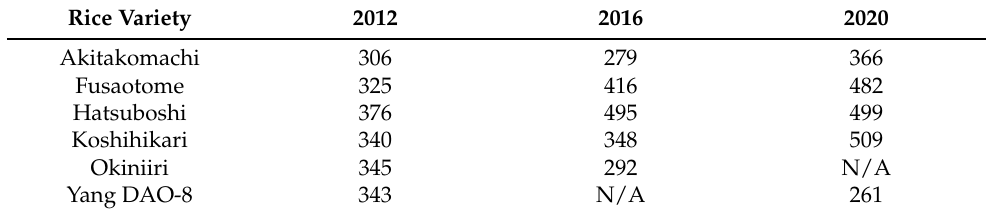
Figure 3. Rice Varieties (harvested in 2012). ( a ) Akitakomachi. ( b ) Fusaotome ( c ) Hatsuboshi. ( d ) Koshihikari. ( e ) Okiniiri. ( f ) Yang Dao-8. Table 1. Rice seed dataset sample